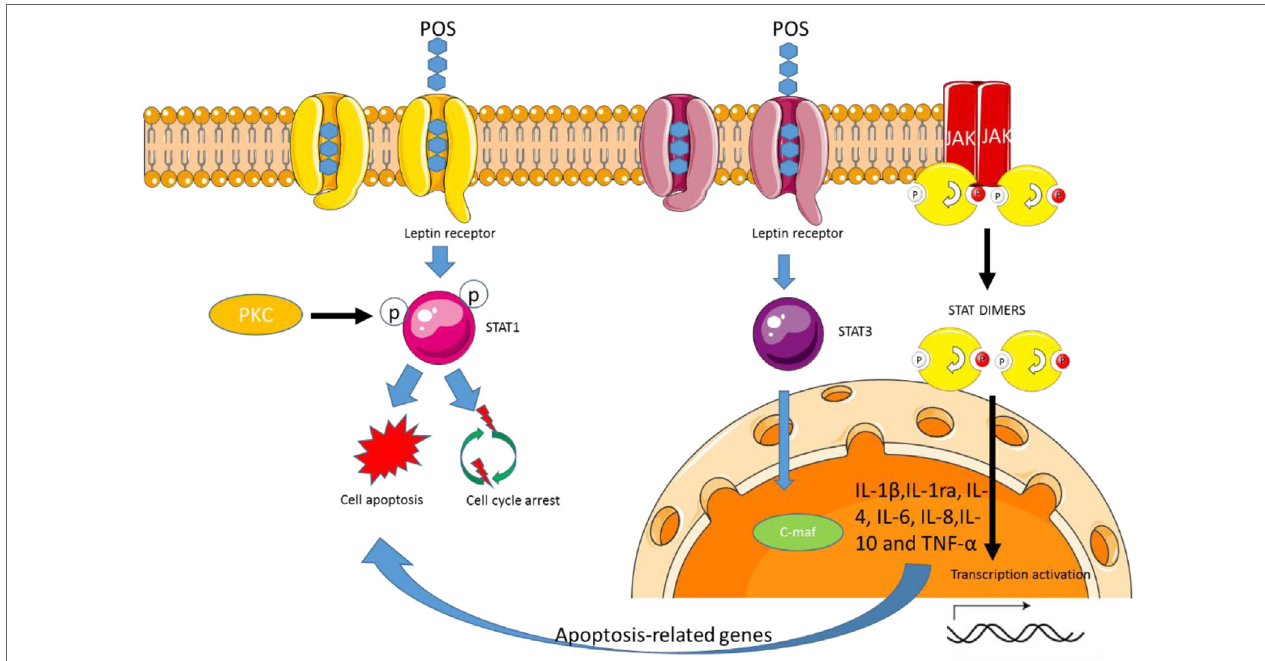
FiguRe 5 | Pectin oligosaccharides (POS) regulates STAT 1 and 3 signaling pathway by the leptin receptor. POS-binding leptin receptor forms signal transduction and transcriptional activator 1 or STAT3 complex, which induces cell apoptosis or cell